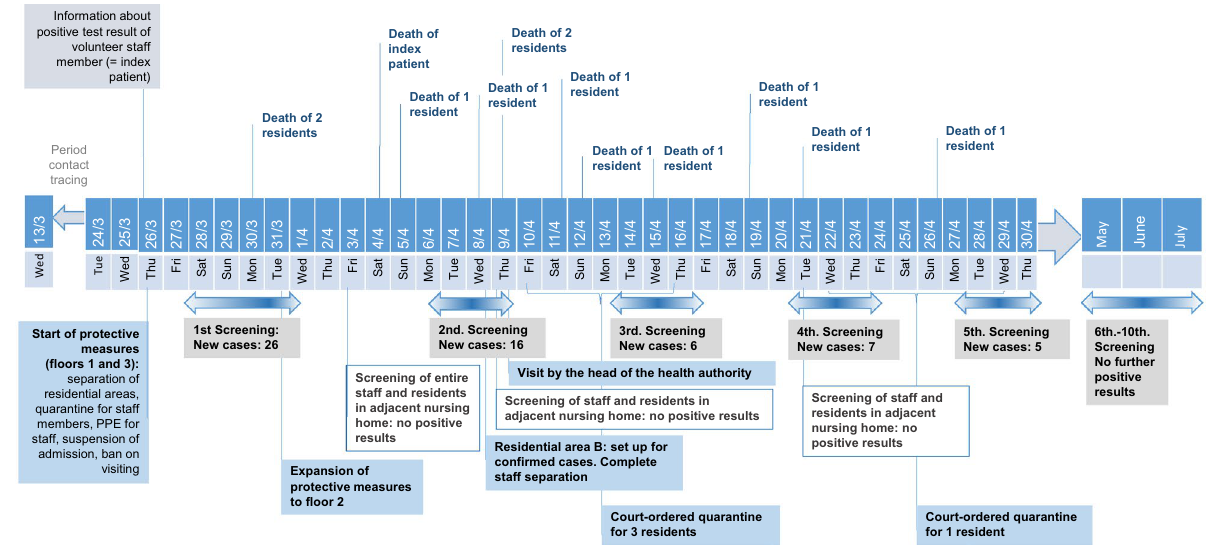
Figure 1. Timeline of events and directed measures in nursing home NH01.a. Graphical representation of the chronological sequence of screenings, new infections, deaths and measures taken to contain the